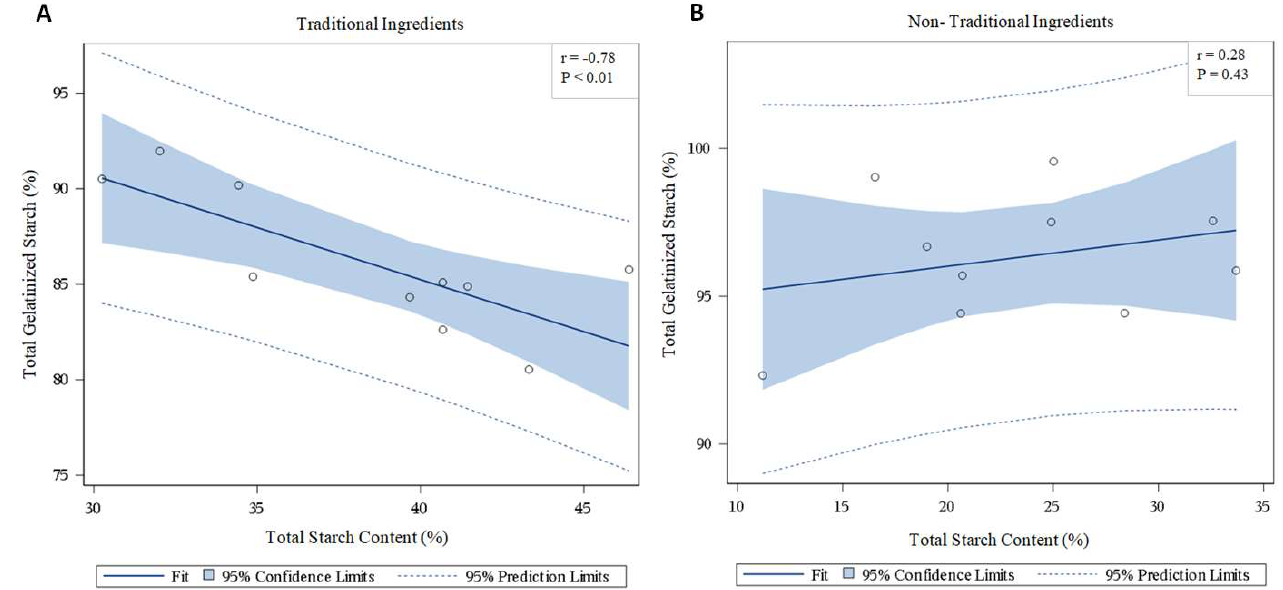
Figure 1. Correlation between starch content and total gelatinization in diets formulated with ( A ) traditional and ( B ) non-traditional ingredients.